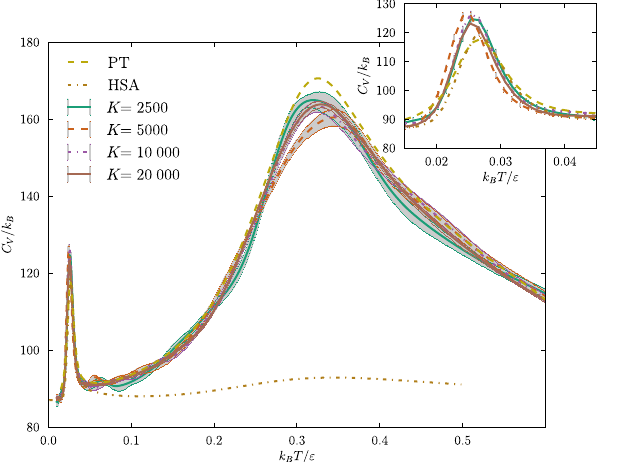
FIG. 3. Heat capacity curves for LJ 75 . The PT and HSA results were obtained by parallel tempering and the harmonic super- position approximation, respectively. Exact SENS calculations were performed using K ¼ 60 000 replicas, while results for approximate SENS calculations are shown for both K ¼ 30 000 and K ¼ 60 000 replicas.